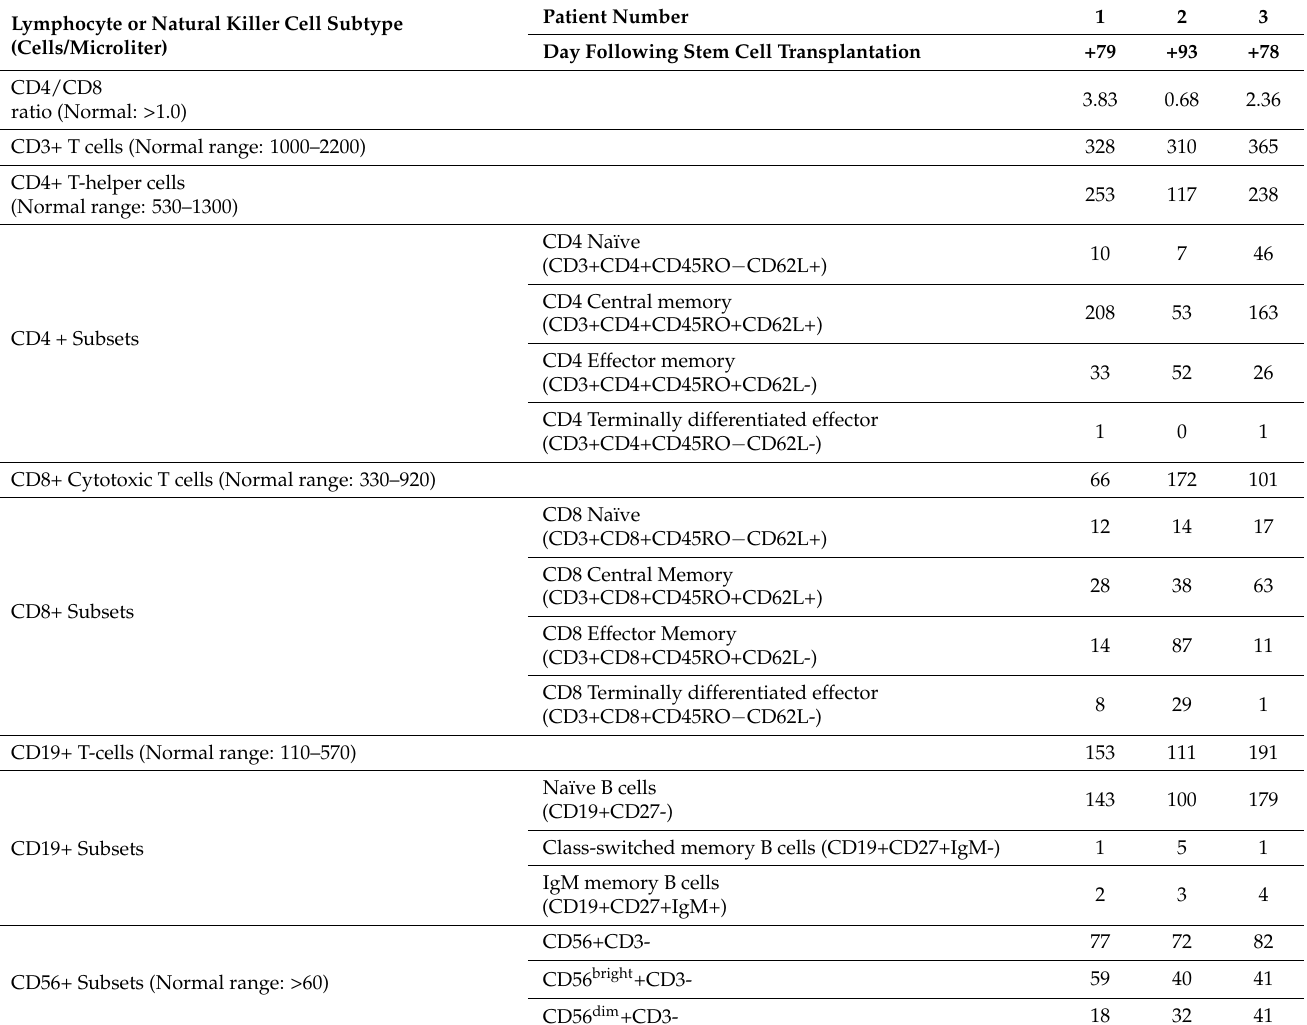
Table 3. Quantitative immune reconstitution of pediatric and adolescent patients following HLA matched-donor HSCT as represented by lymphocyte subsets and natural killer cell counts. CD45RO+ cells indicate memory T cells while CD45RO − cells are a more naïve phenotype. All counts are in cells/microliter. Subsets were defined as the following: central memory cells when expressing CD45RO+ CD62L+, CD45RO+ CD62L- as effector memory T cells, CD45RO-CD62L+ as naïve central memory cells, and CD45RO-CD62L- as naïve effector memory cells. Natural killer (NK) cells are represented by CD56+ cells while CD56+ bright cells are cytokines that produce immunoregulatory cells and CD56 dim cells represent cytotoxic NK